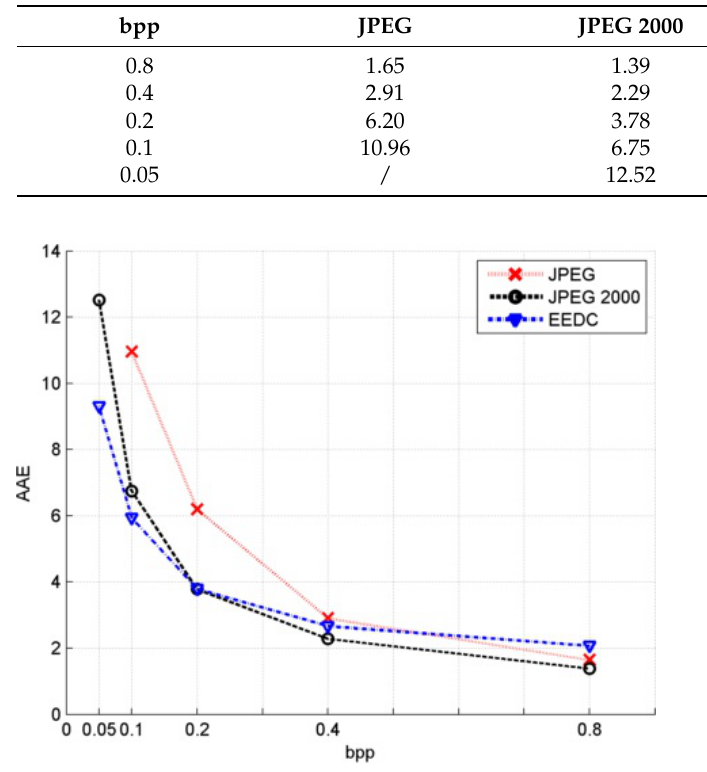
Table 2. Comparison of Average Absolute Error for image horse on an unmodified compression algorithm.